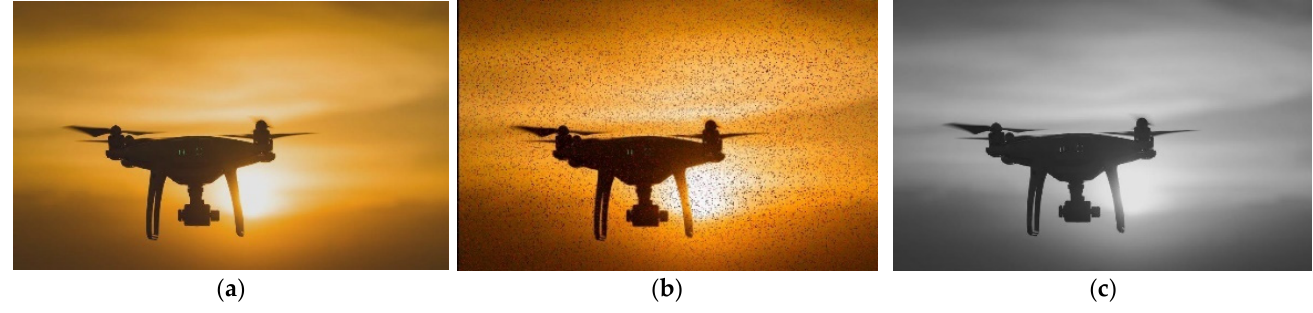
Figure 7. Original and data-enhanced images: ( a ) original, ( b ) randomly noise-increased; ( c ) bina- rized.